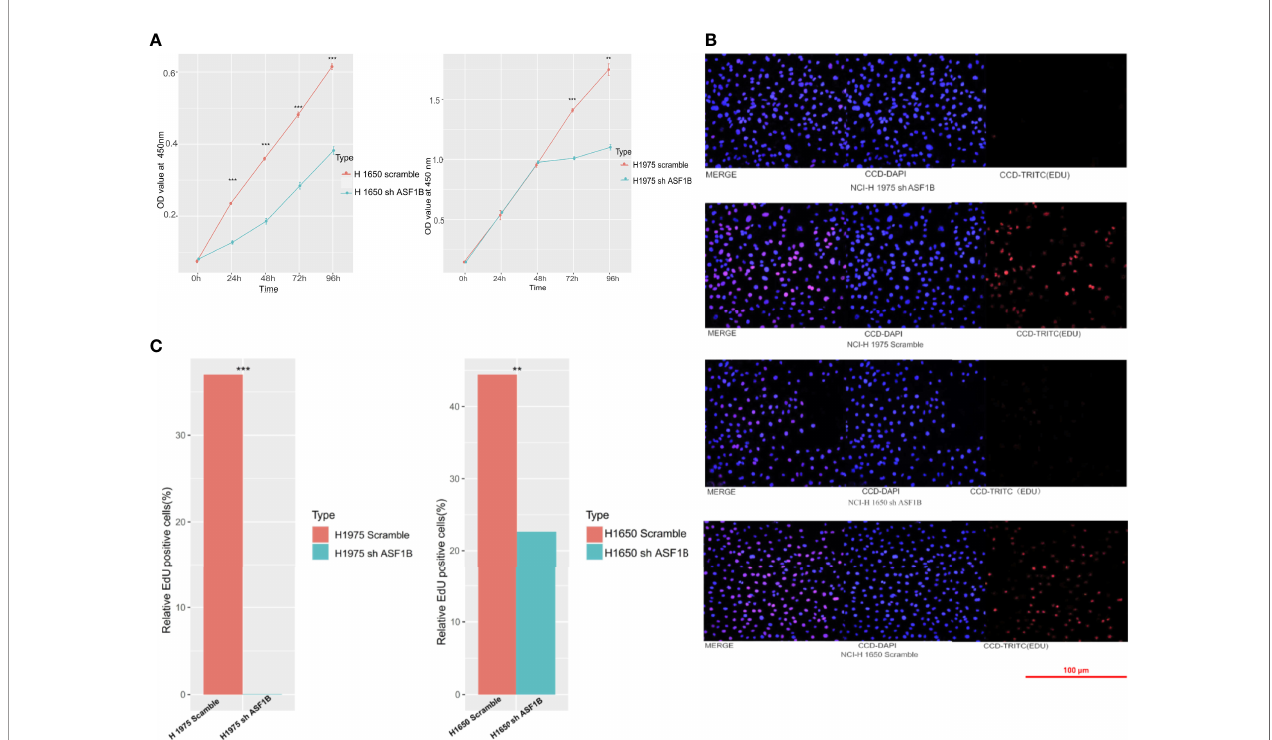
FIGURE 7 | (A) Cellviability assayofH1975 and H1650 cells. (B) Cellproliferation assay of H1975 and H1650 cells. (C) Accumulated analysisofthe cellproliferation. **p vaule ≤ 0.01; ***p vaule ≤